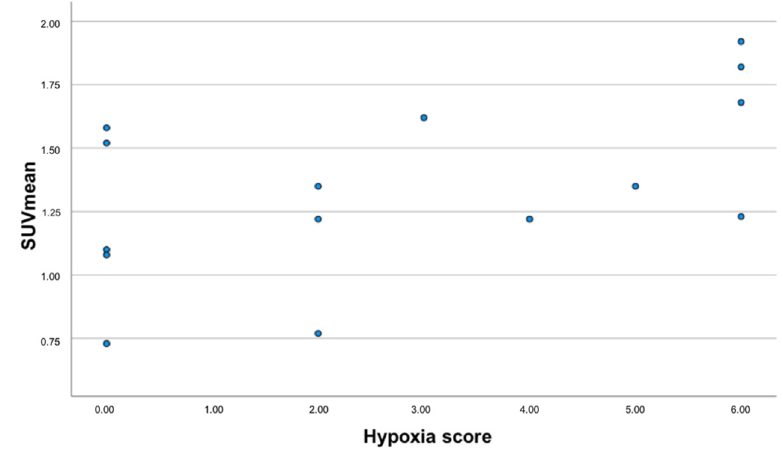
Figure 4. Scatterplot showing the relationship between the hypoxia score (data shown in the X-axis) and SUVmean of the primary tumor derived from the delayed 68Ga-Nitroimidazole PET images. and SUVmean of the primary tumor derived from the delayed 68 Ga-Nitroimidazole PET Table 3. SUVmax and TMR from the 18F-FDG and 68Ga-Nitroimidazole PET/CT scans correlated with the HIF-1 α expression.